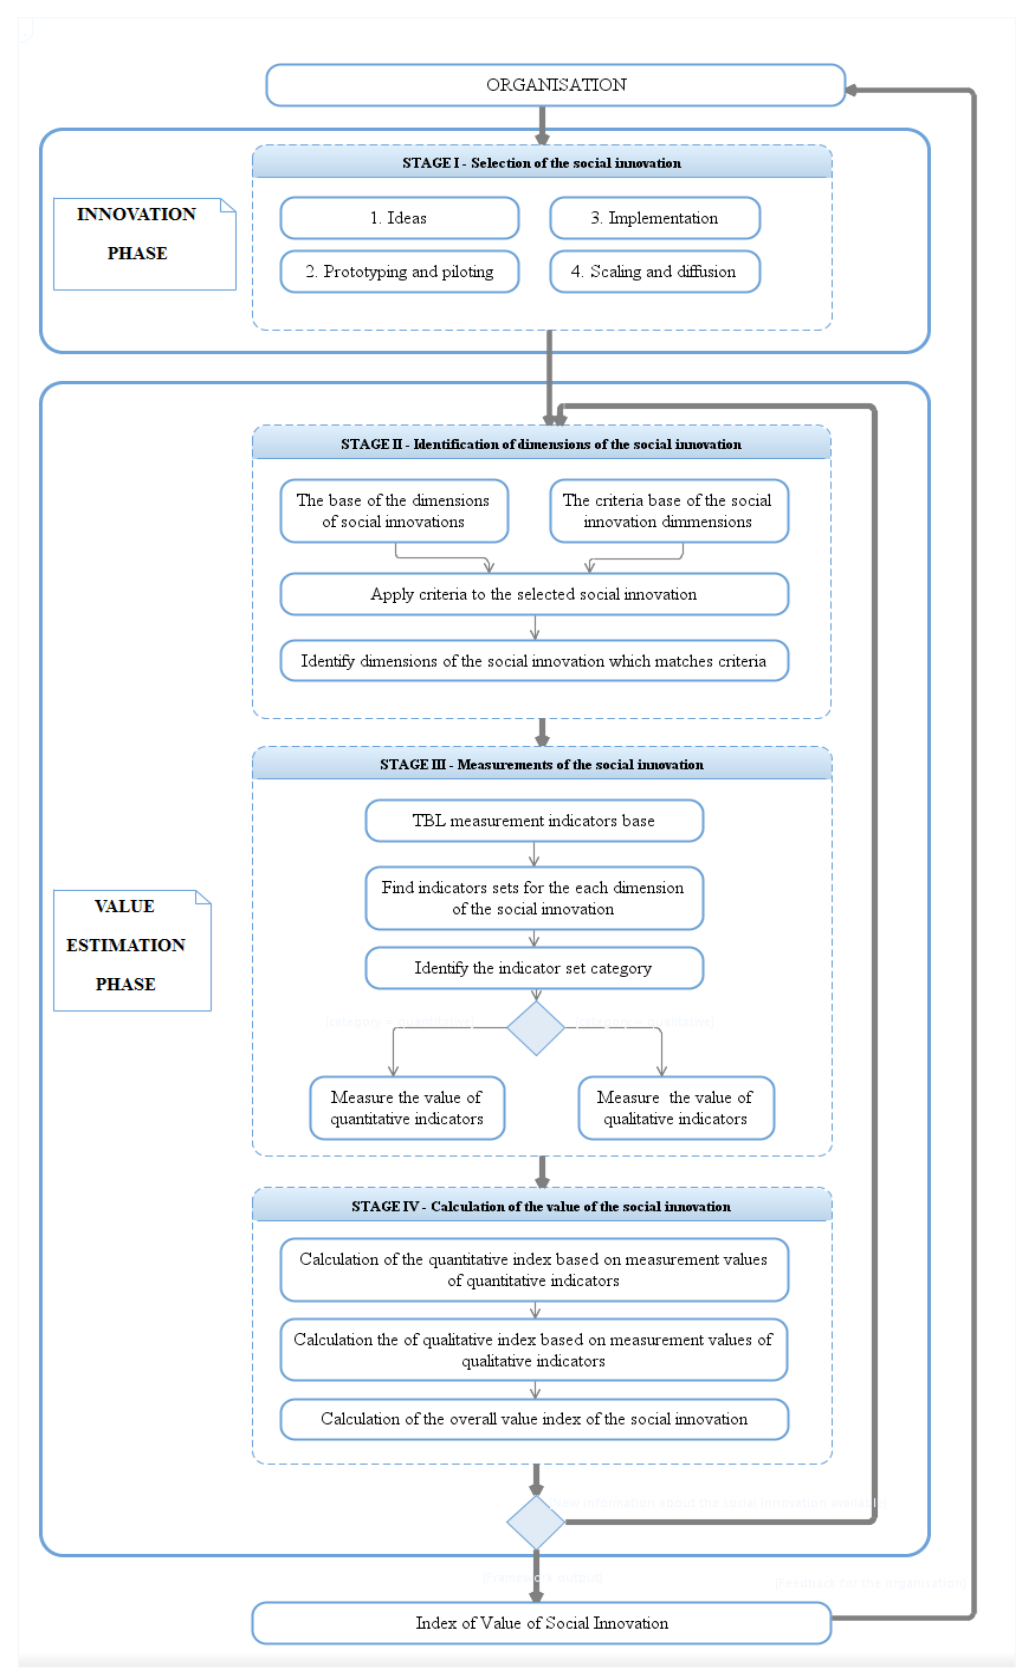
Fig. 2. The conceptual model for measuring the value of social innovation at an organisation’s